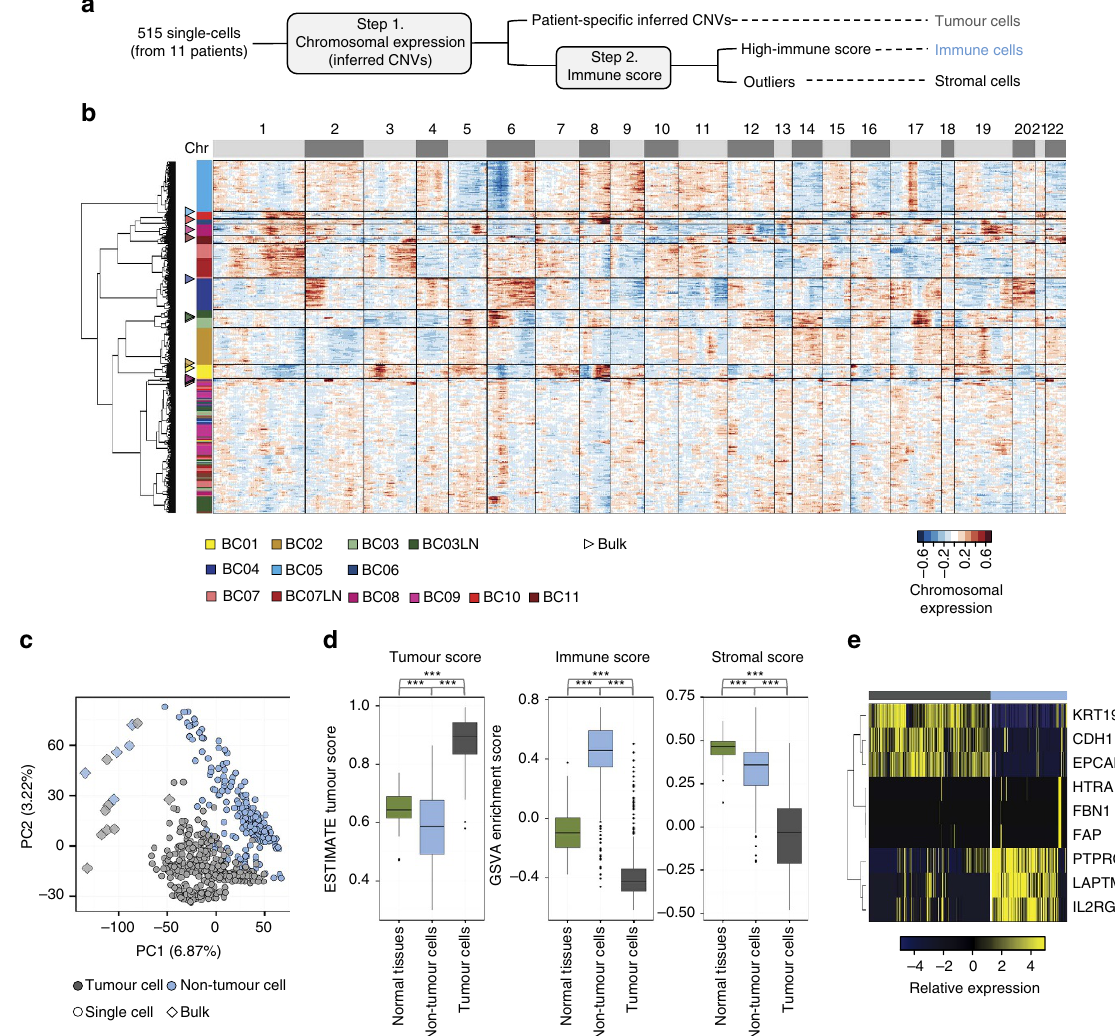
Figure 2 | Separation of carcinoma and non-carcinoma cells. ( a ) Scheme of cell classification. ( b ) Hierarchical clustering of the chromosomal gene expression pattern separating the patient-specific carcinoma cell groups from the non-carcinoma cell cluster. Each row represents single cells and matched bulk tumours (triangle): the tumour groups are colour-coded as in Fig. 1a. For each chromosome, the chromosomal gene expression pattern was estimated from the moving average of 150 genes. These patterns implicate chromosomal amplification and deletion. ( c ) Unsupervised PCA showing the separation of carcinoma and non-carcinoma cell groups. ( d ) Carcinoma cells identified in a , scored low for stromal and immune signatures, whereas non-carcinoma cells scored high for immune signatures. Tumour score was inferred from the stromal and immune signature using ESTIMATE algorithm 26 . Normal tissues represent 183 mammary tissue data from GTEx portal (http://www.gtexportal.org/). Each box shows the median and interquartile range (IQR 25th–75th percentiles), whiskers indicate the highest and lowest value within 1.5 times the IQR and outliers are marked as dots. P value, Student’s t -test (*** P o 0.001). ( e ) Representative gene expression in single cells for the immune ( PTPRC , LAPTM5 and IL2RG ), stromal ( HTRA1 , FBN1 and FAP ) and epithelial ( KRT19 , CDH1 and EPCAM ) cell